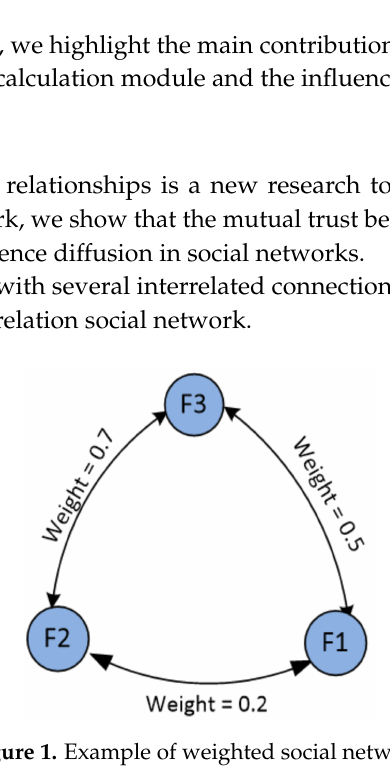
Figure 1. Example of weighted social